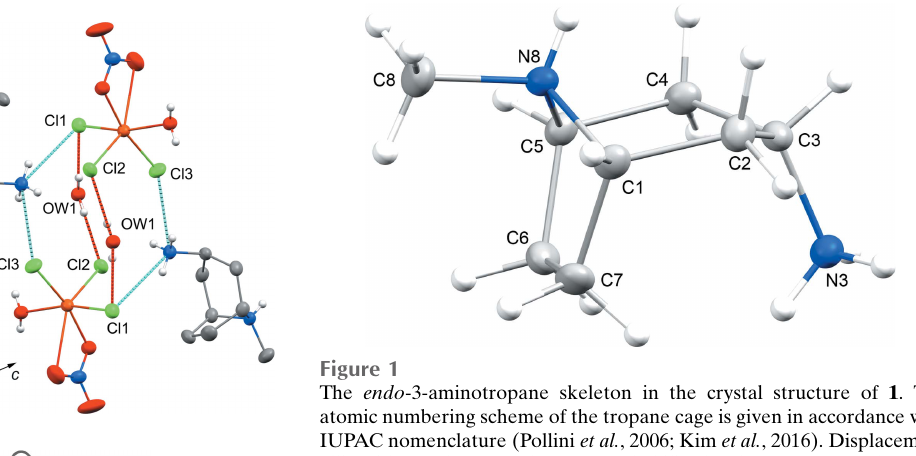
atomic numbering scheme of the tropane cage is given in accordance with IUPAC nomenclature (Pollini et al. , 2006; Kim et al. , 2016). Displacement ellipsoids are drawn at the 30% probability level. H atoms are shown as fixed-size spheres of 0.15 A˚